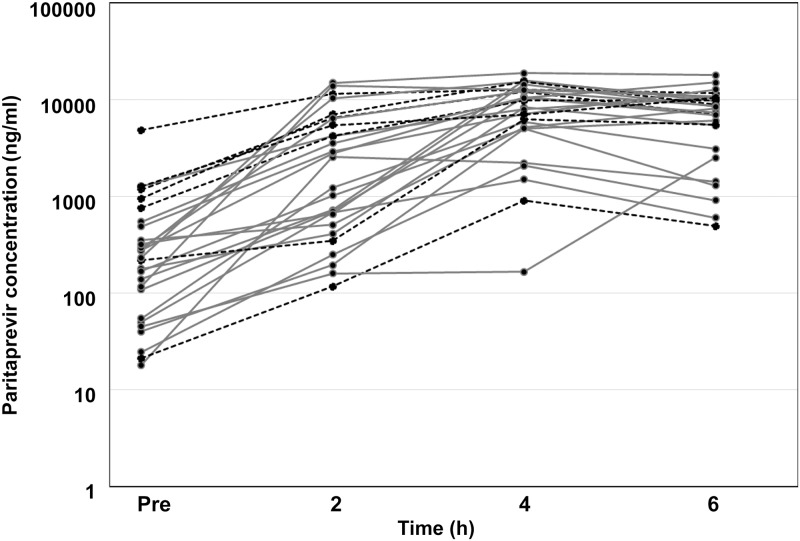
Time profile of plasma paritaprevir concentration 7 d after the start of treatment in each patient (trough concentration, concentration at 2 h, 4 h, and 6 h after dosing).Gray line, patients without hyperbilirubinemia (N = 20); black dotted line, patients with hyperbilirubinemia (N = 7).